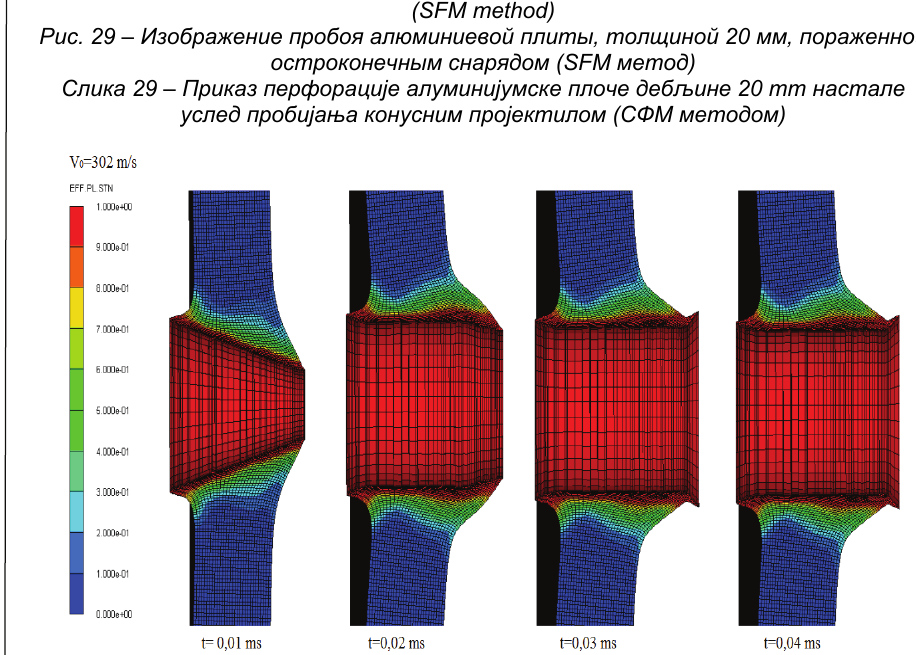
Figure 30 – Perforation of a 15 mm thick aluminum plate by a conical projectile (SFM method) Рис . 30 – Изображение пробоя алюминиевой плиты , толщиной 15 мм ,